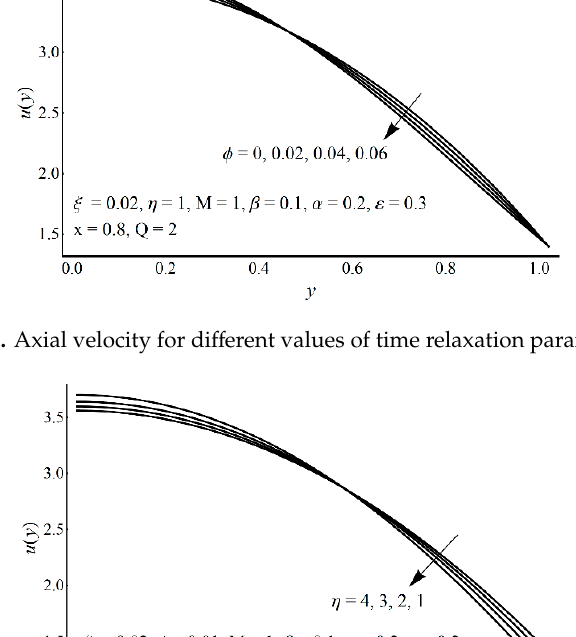
Figure 3. Axial velocity for various values of velocity slip parameter ξ .